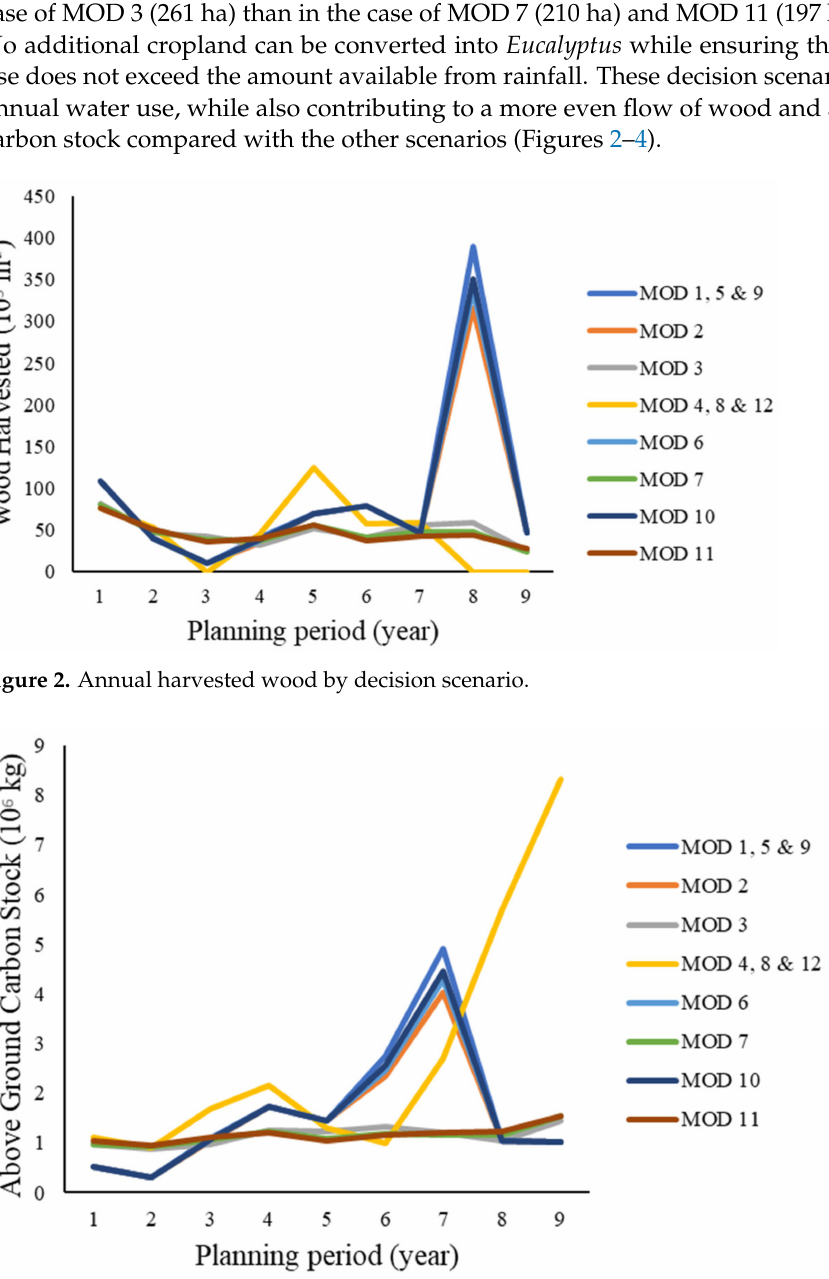
Figure 3. Annual aboveground carbon stock by decision